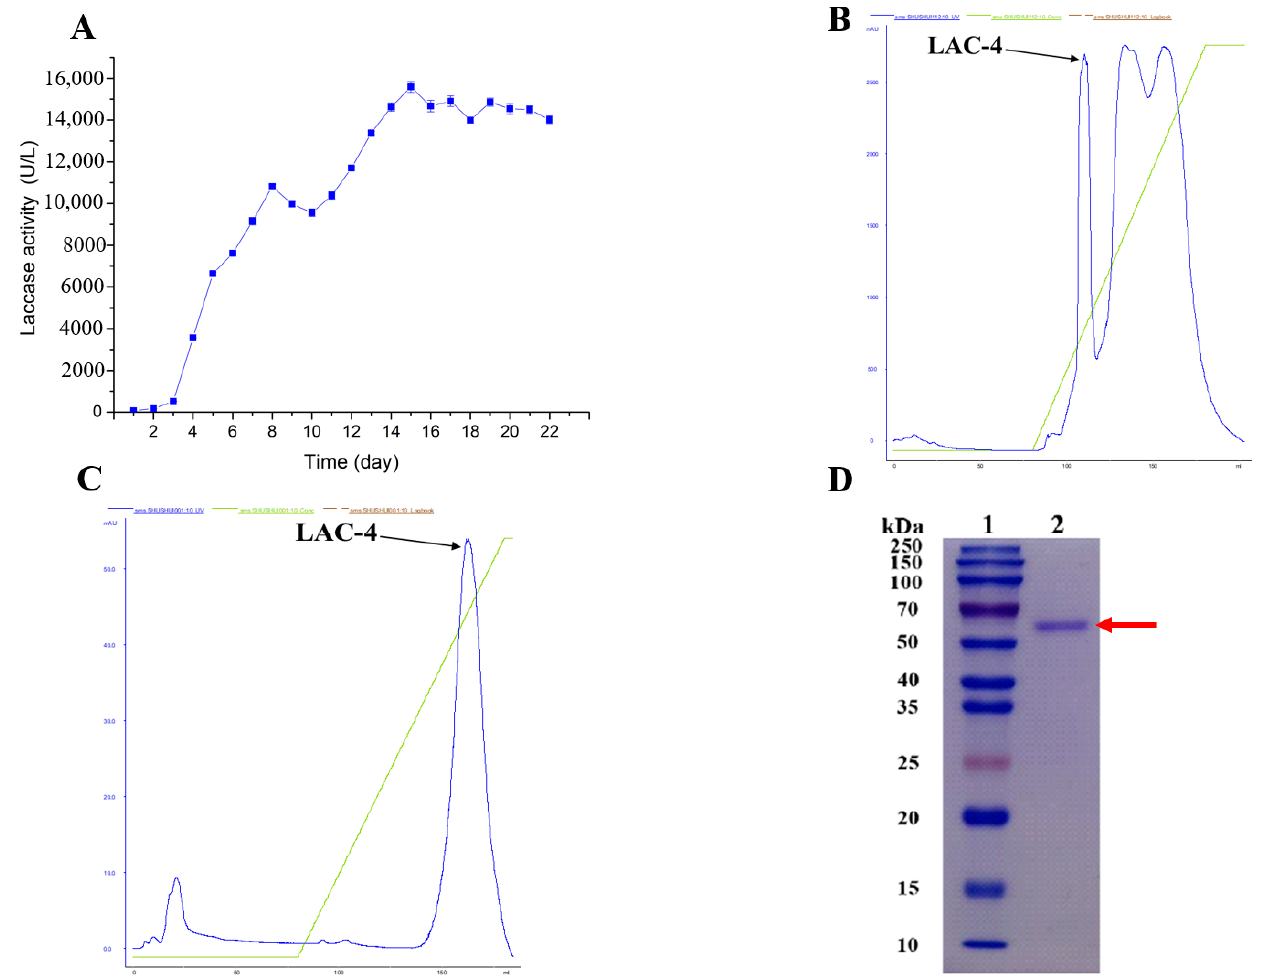
Figure 1. Purification of LAC-4 laccase from white-rot fungus Ganoderma lucidum . ( A ) Change curve of laccase production by Ganoderma lucidum in GYP medium. CuSO 4 was added on the third day of incubation to induce laccase expression. ( B ) The chromatographic profile of LAC-4 (anion chromatography). ( C ) The chromatographic profile of LAC-4 (hydrophobic interaction chromatography). ( D ) Detection of purified LAC-4 laccase by SDS-PAGE electrophoresis. Lane 1: protein molecular mass marker; Lane 2: purified LAC-4 laccase.